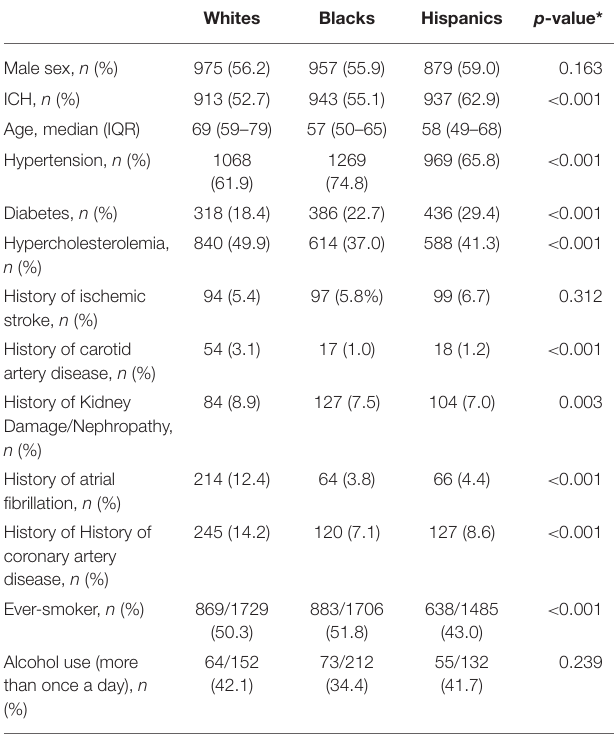
TABLE 1 | Sample demographic and clinical characteristics ( n =